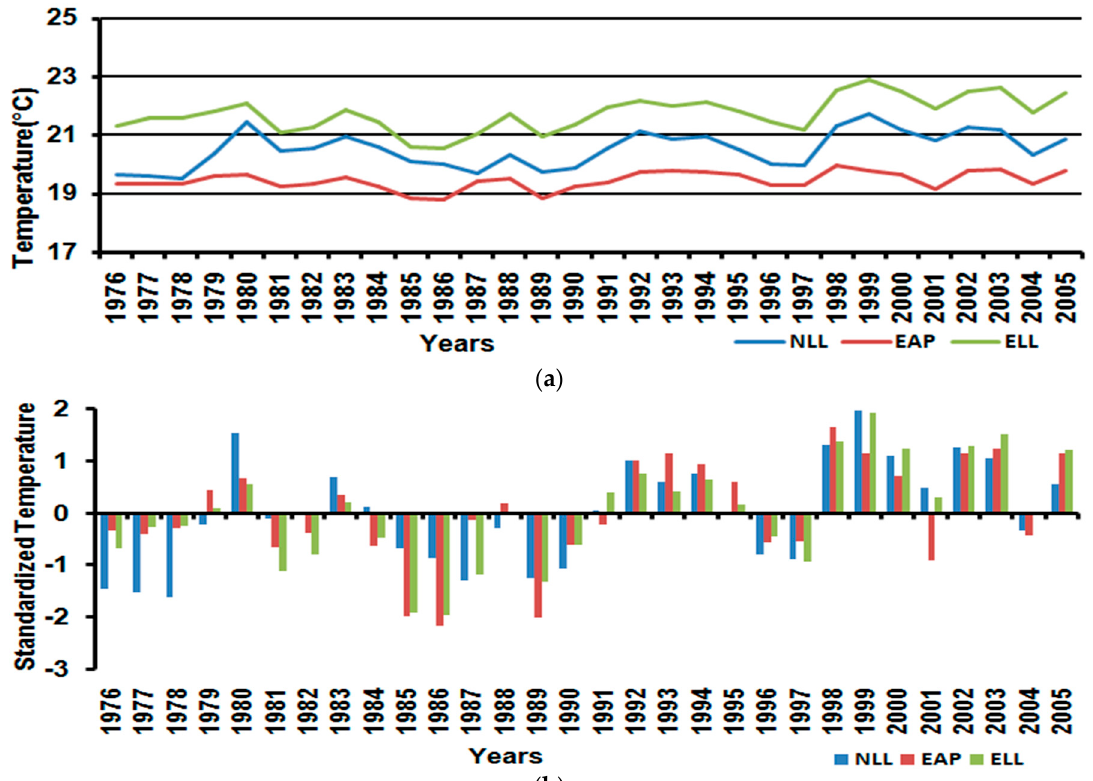
Figure 3. Interannual ( a ) temperature patterns; ( b ) standardized temperature at NLL, EAP and ELL over the period 1976–2005.